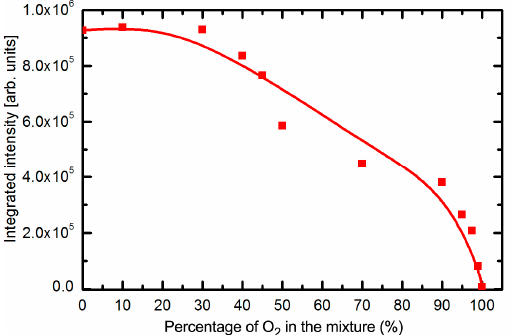
Figure 3. Integral radiation in the UV range versus oxygen concentration in SO 2 + O 2 mixture. Zero percent of O 2 in the mixture refers to pure SO 2 plasma, whereas 100% of O 2 refers to pure oxygen plasma.